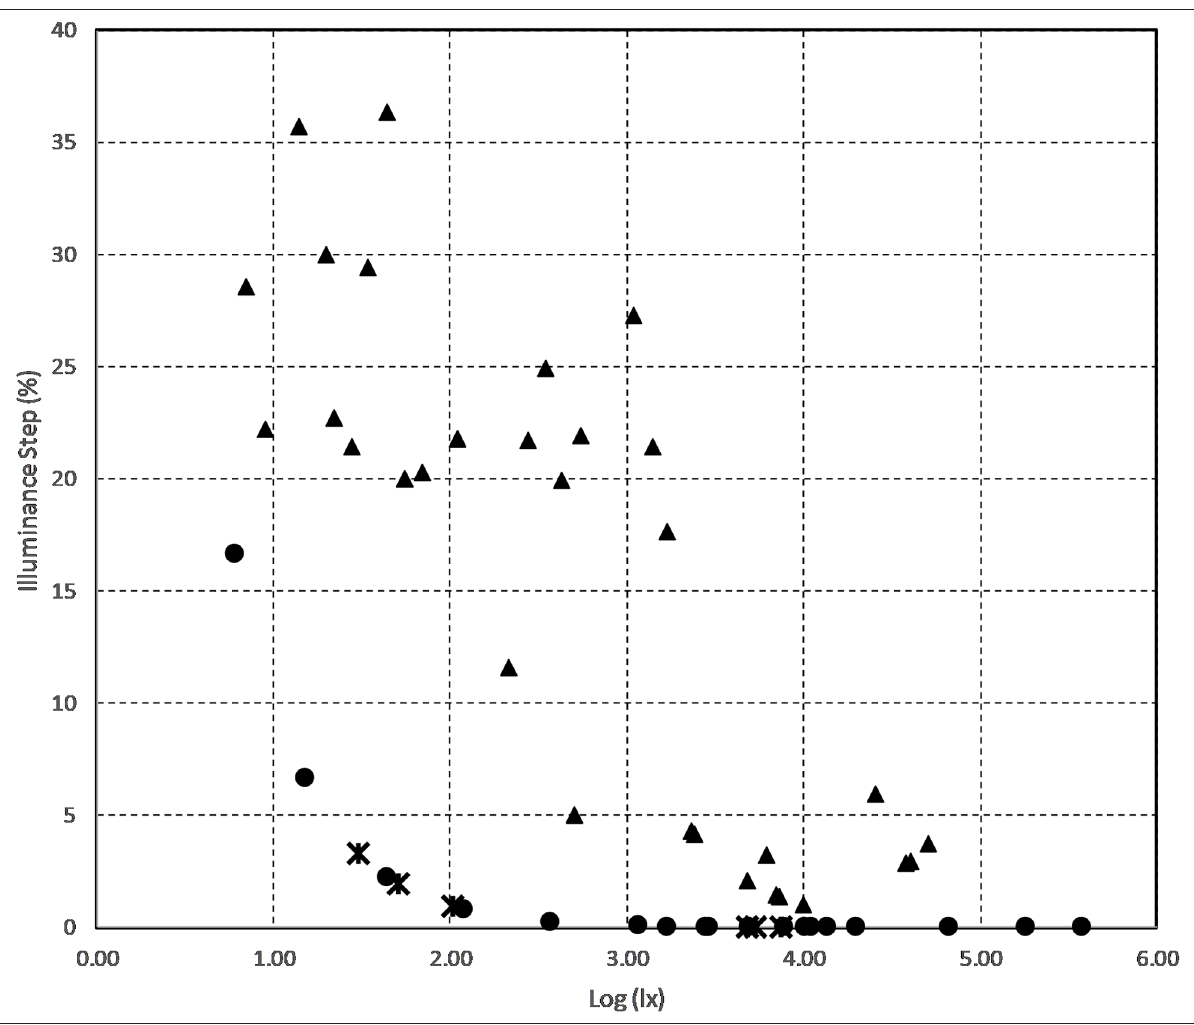
Figure 1: The percentage change of the measurement step interval to applied illuminance for the camera-based iOS apps: Galactica ( triangle ), Light Meter by Polyanskaya ( asterisk ), and the sensor-based Android app Light Meter by WBPhoto